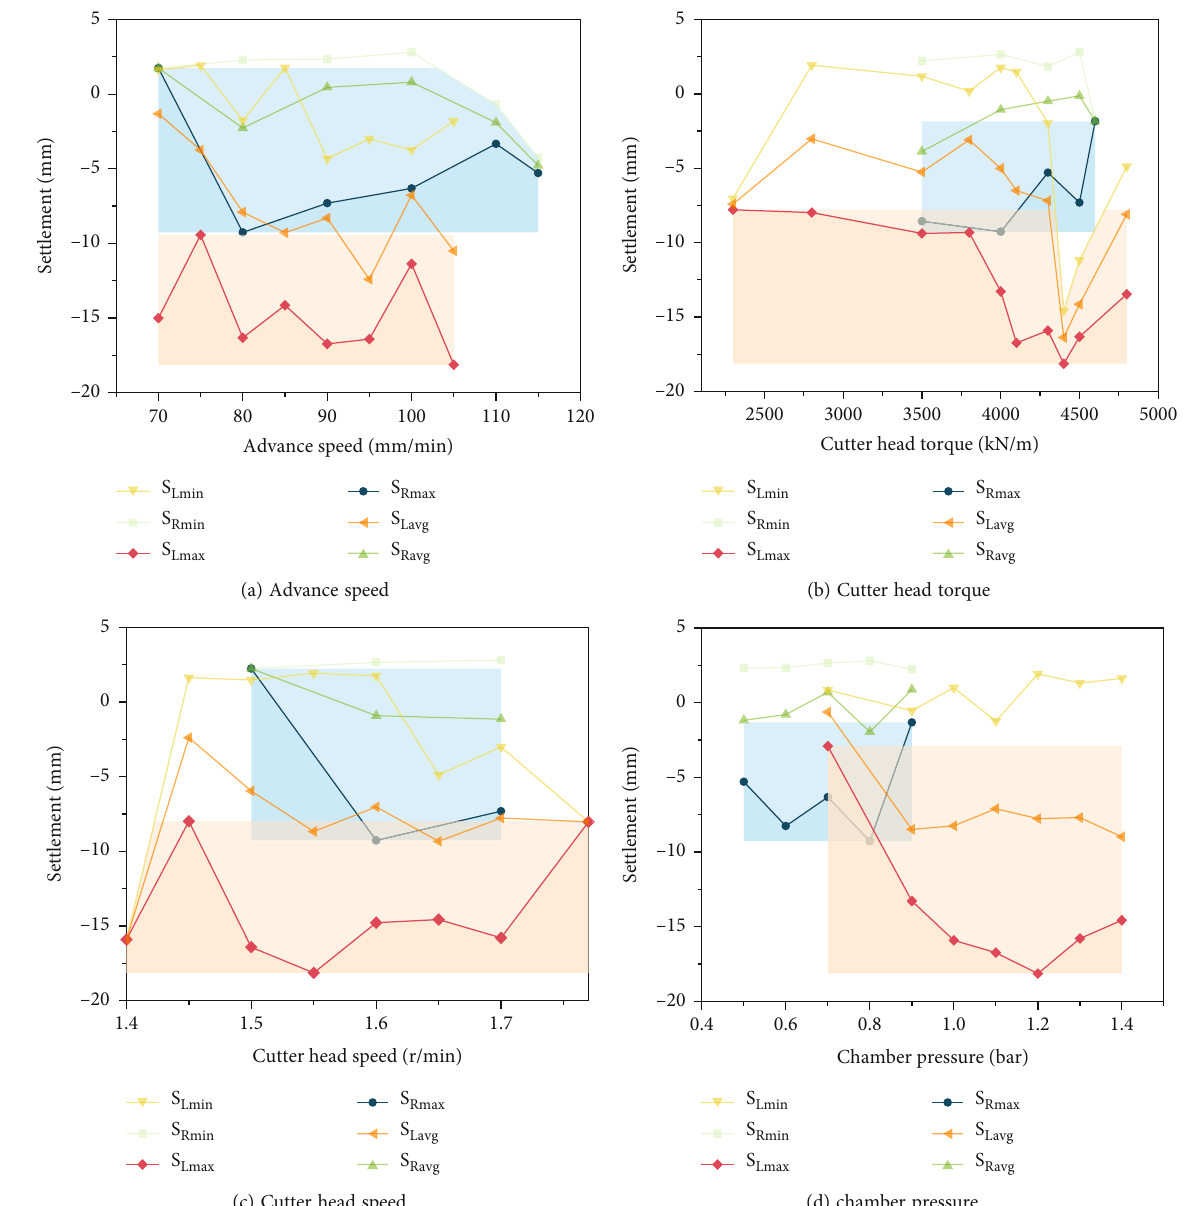
Figure 15: Relationship between surface settlement and driving